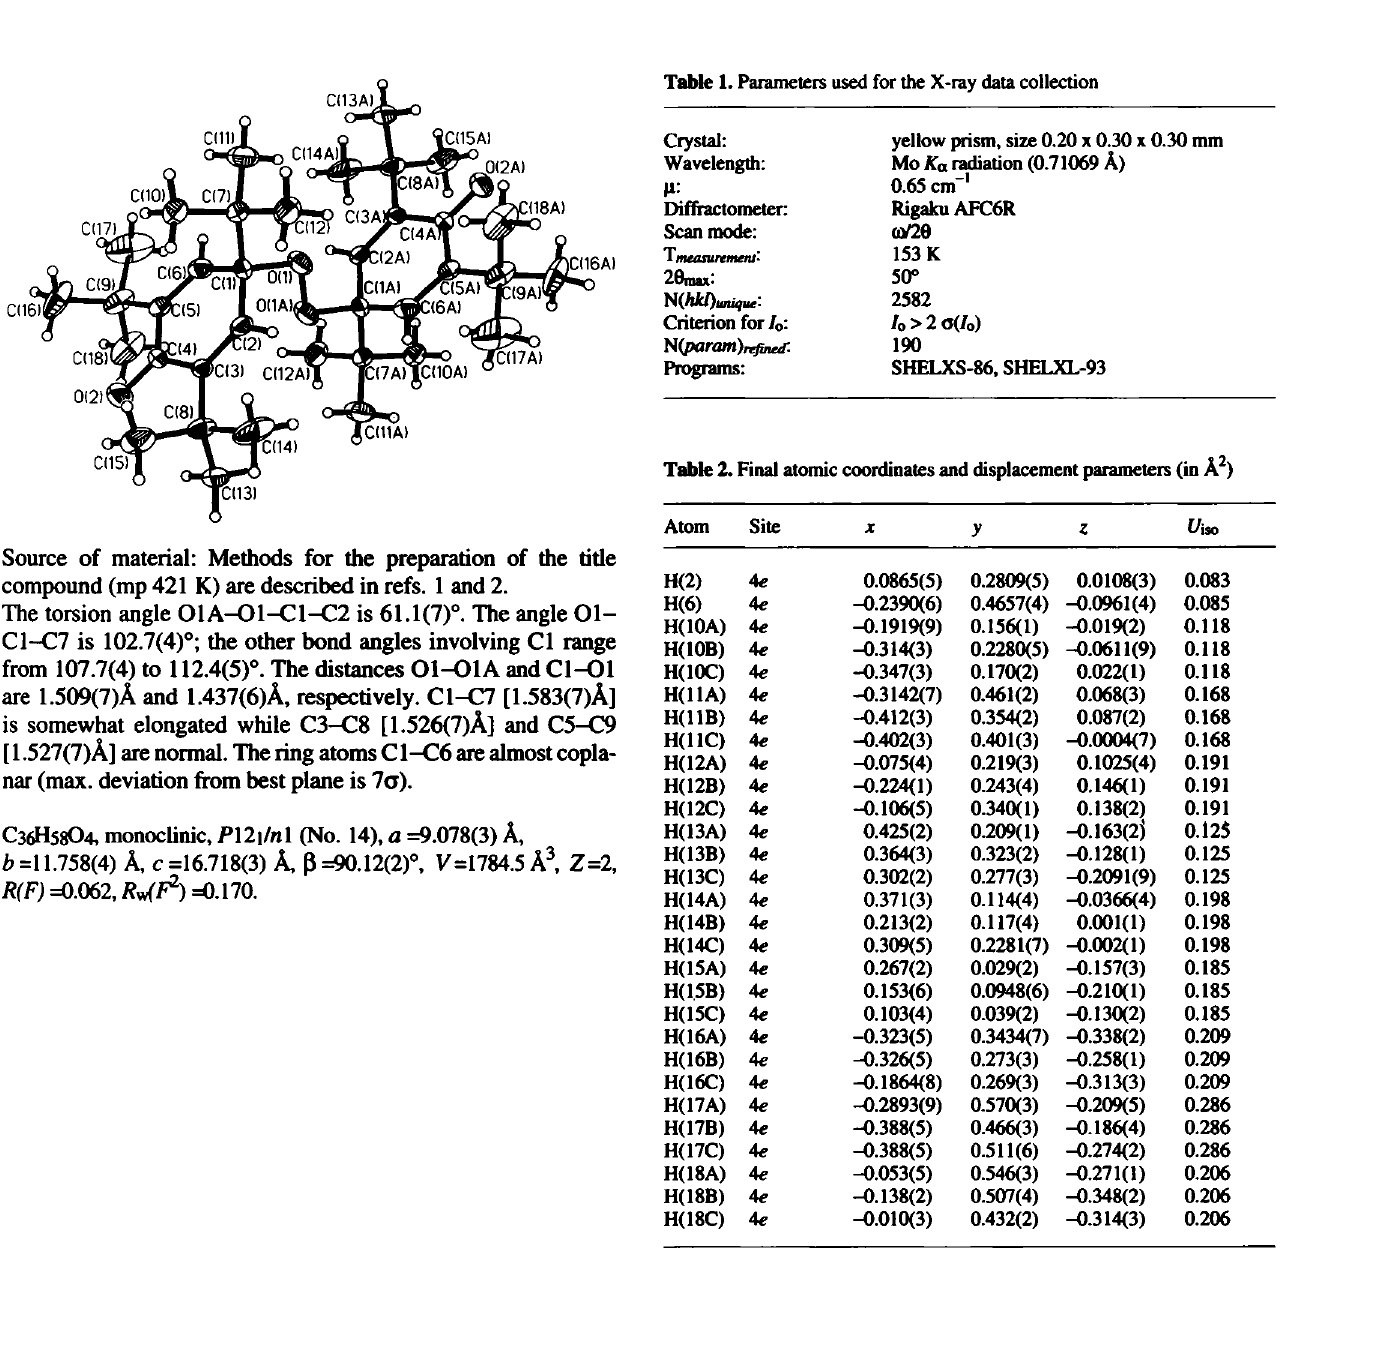
Table 1. Parameters used for the X-ray data collection Crystal: